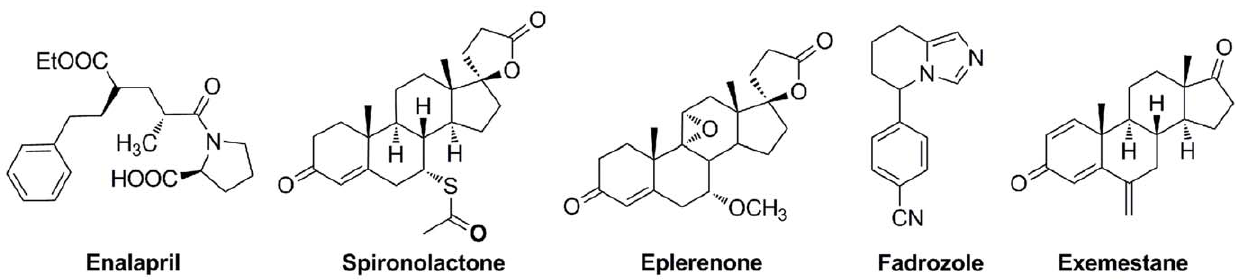
Figure 1. Structures of ACE inhibitor Enalapril, MR antagonists Spironolactone and Eplerenone, CYP11B2 inhibitor Fadrozole and aromatase inhibitor Exemestane.